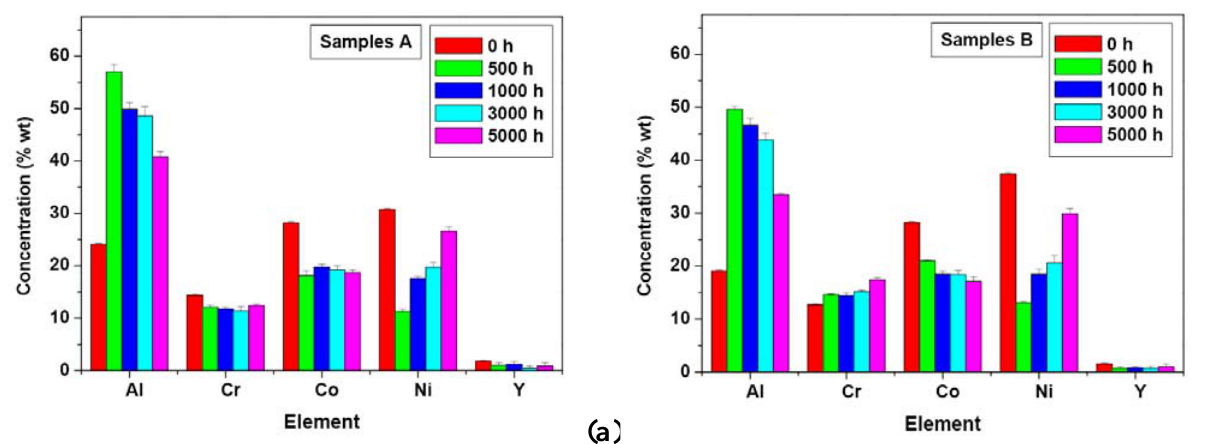
Figure 11. (a) Surface composition measured by EDX analysis of samples A before and after different periods of oxidation at 1,273 K. (b) Surface composition of samples B before and after different periods of oxidation at 1,273